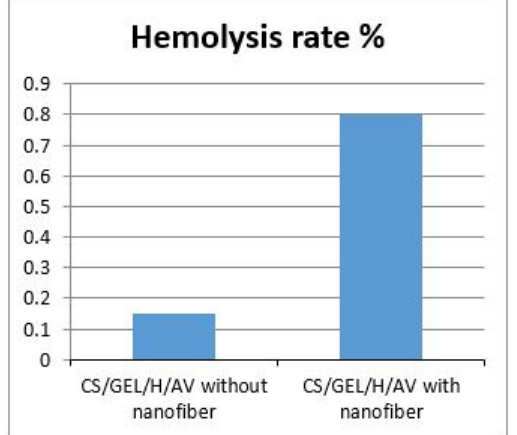
Fig. 11.Curves of hemolysis rate of thin films without and with Figure 11 .Curves of hemolysis rate of thin films without and with nanofiber